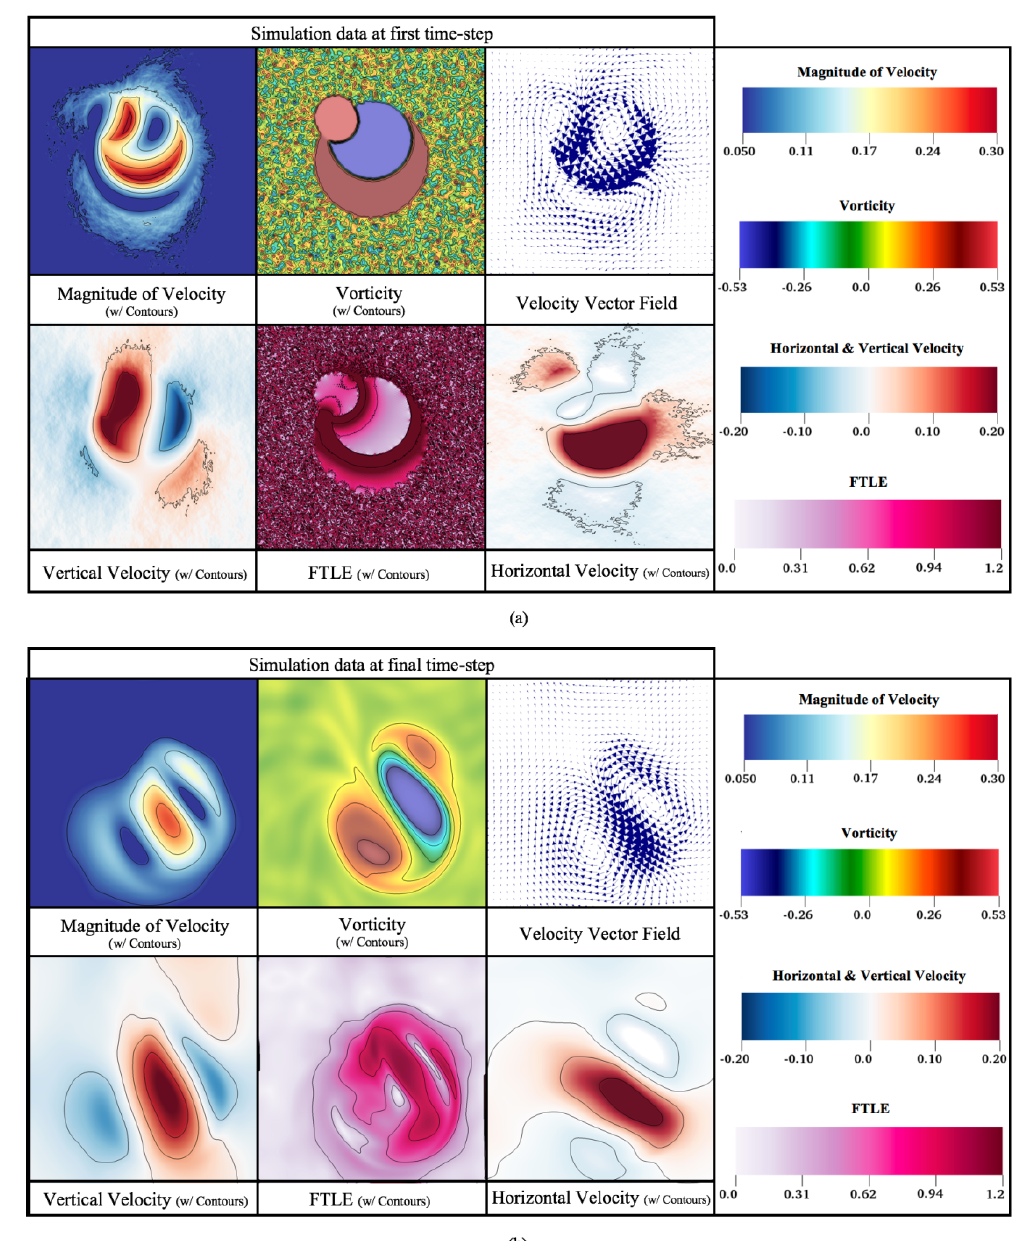
Figure A5. Simulation data from the case of overlapping vorticity regions during ( a ) the first time-step and ( b ) the final